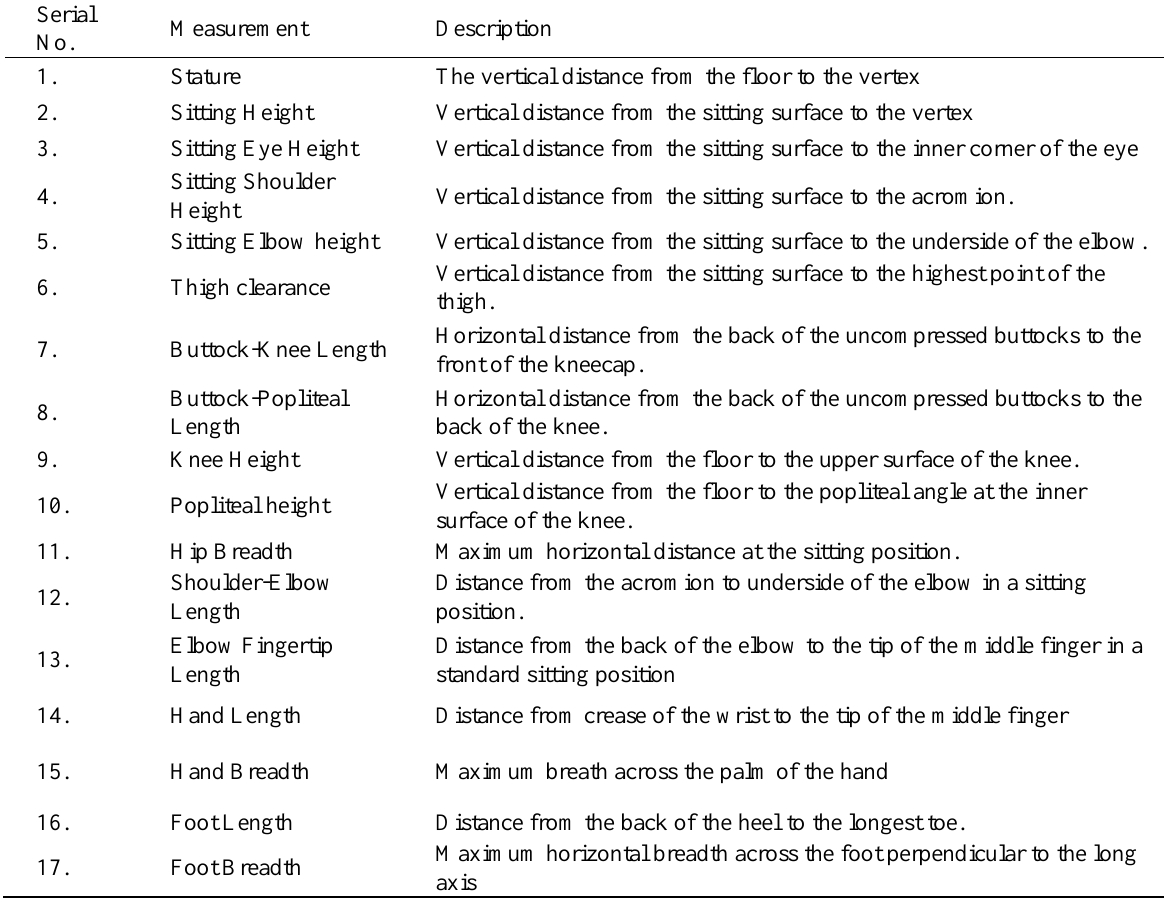
Table 1. Anthropometric measured